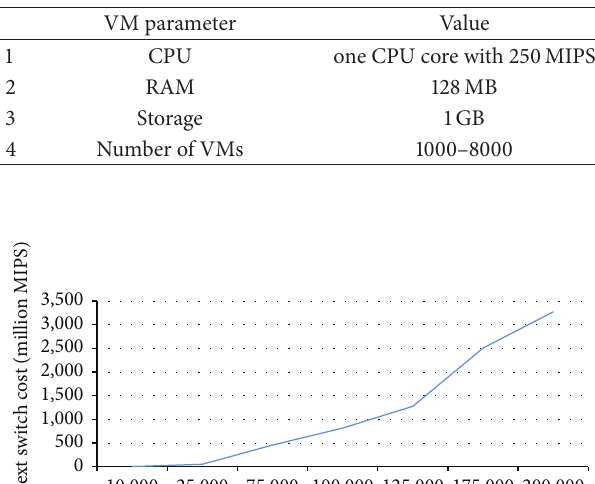
Table 3: VM Parameters.